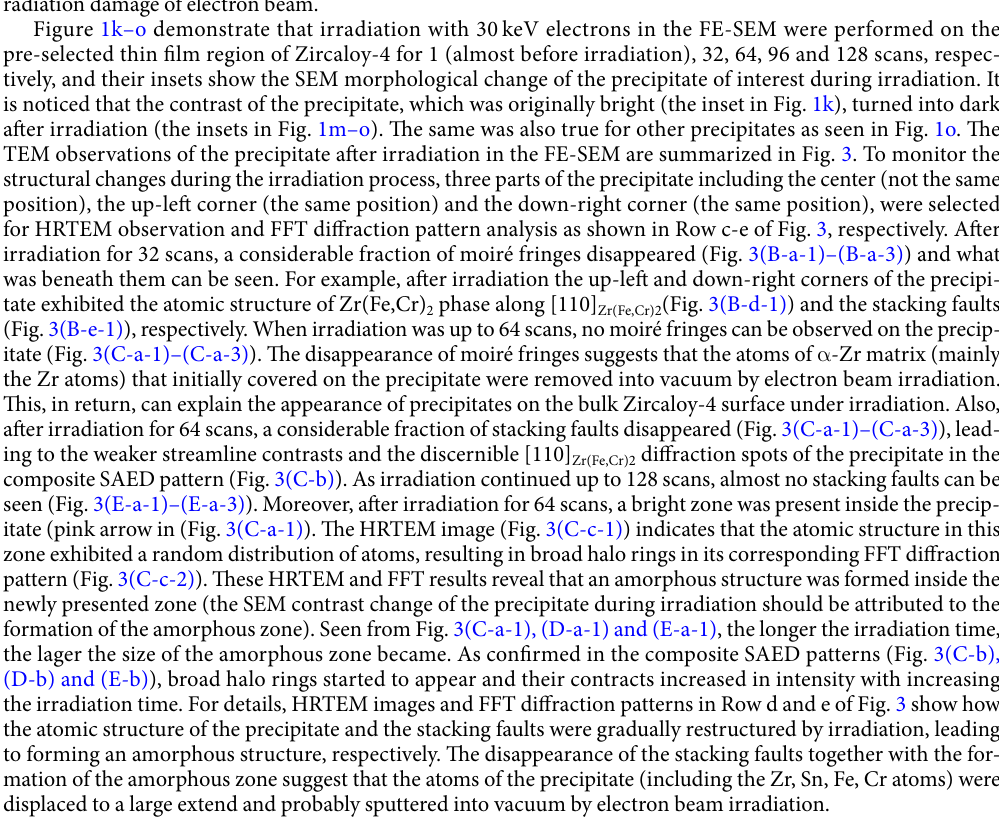
4 Scientific RepoRts | 7: 184 | DOI:10.1038/s41598-017-00251-3